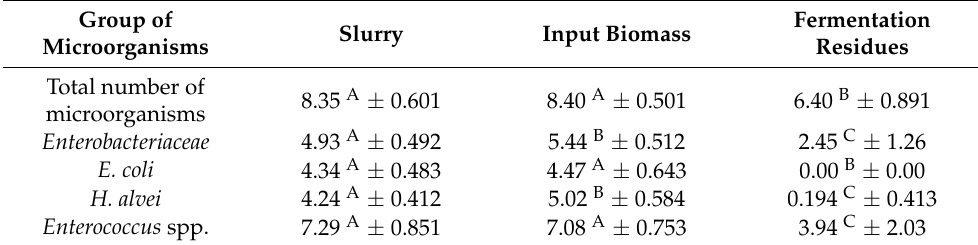
Fermentation Residues